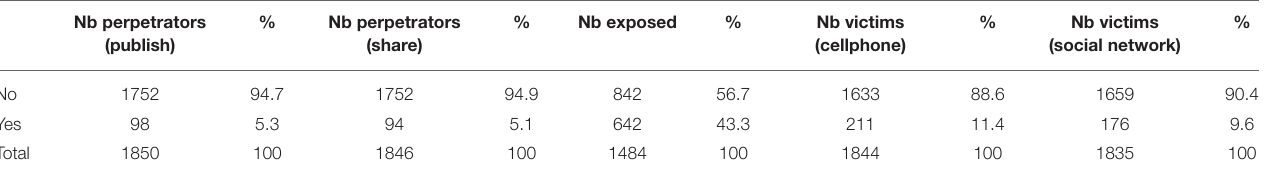
TABLE 1 | Numbers and proportions of perpetrators and victims of hateful content.